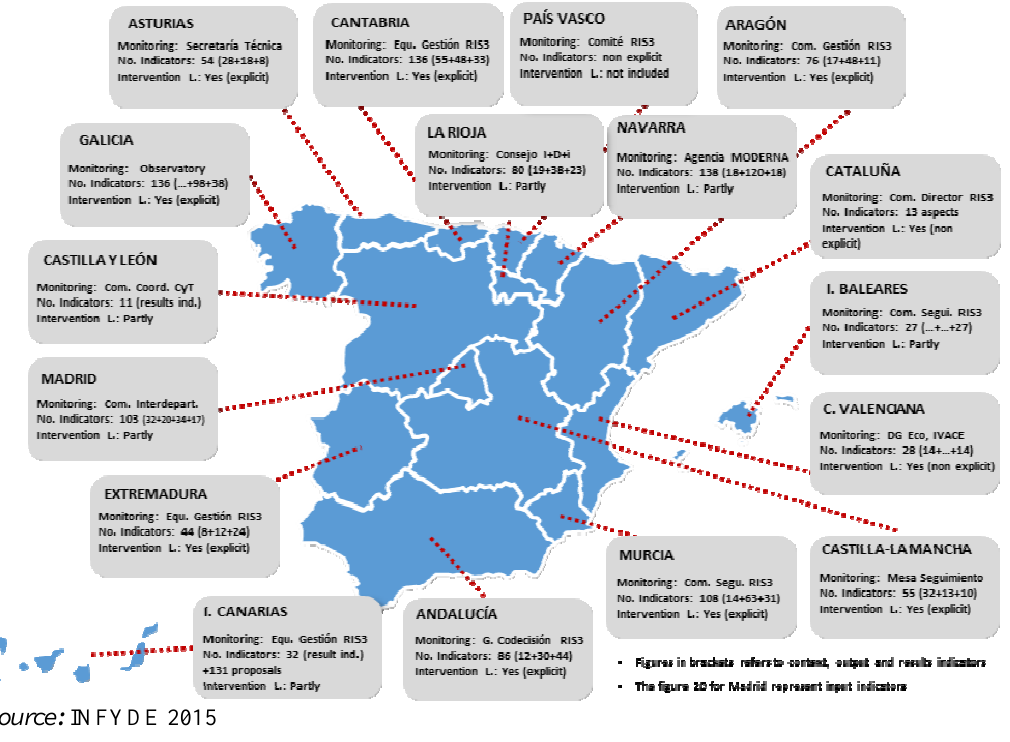
Figure 4: Brief Summary of Monitoring end Evaluation Systems in Spanish